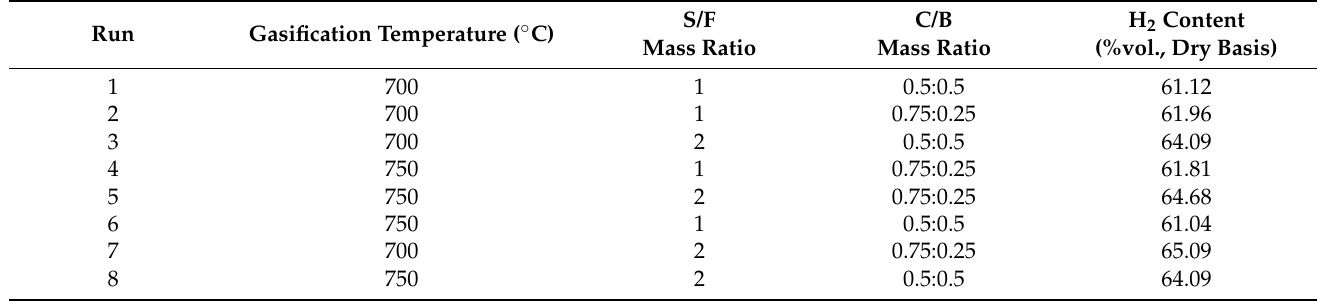
Table 4. The response results from the 2 3 factorial experimental design analysis of the co-gasification of biomass and coal with Aspen Plus simulator version 10.